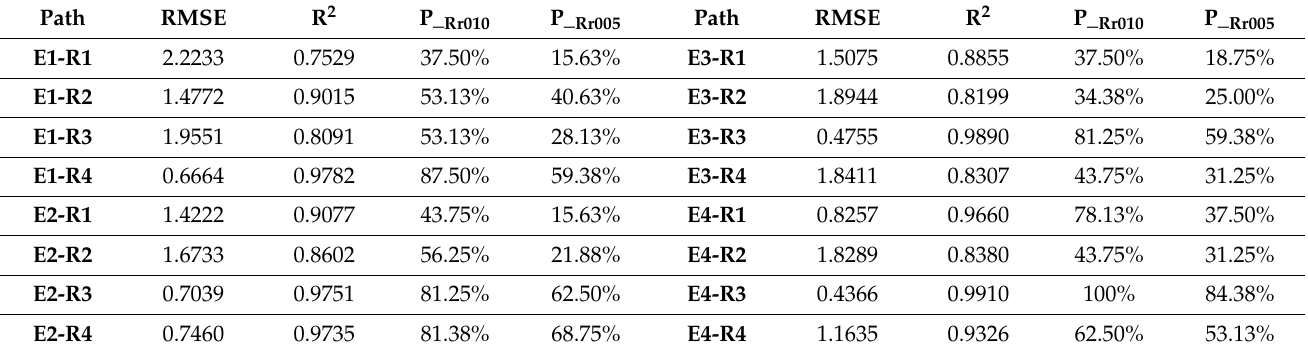
Table 5. Evaluation metric of the 16 path models before reconstruction.